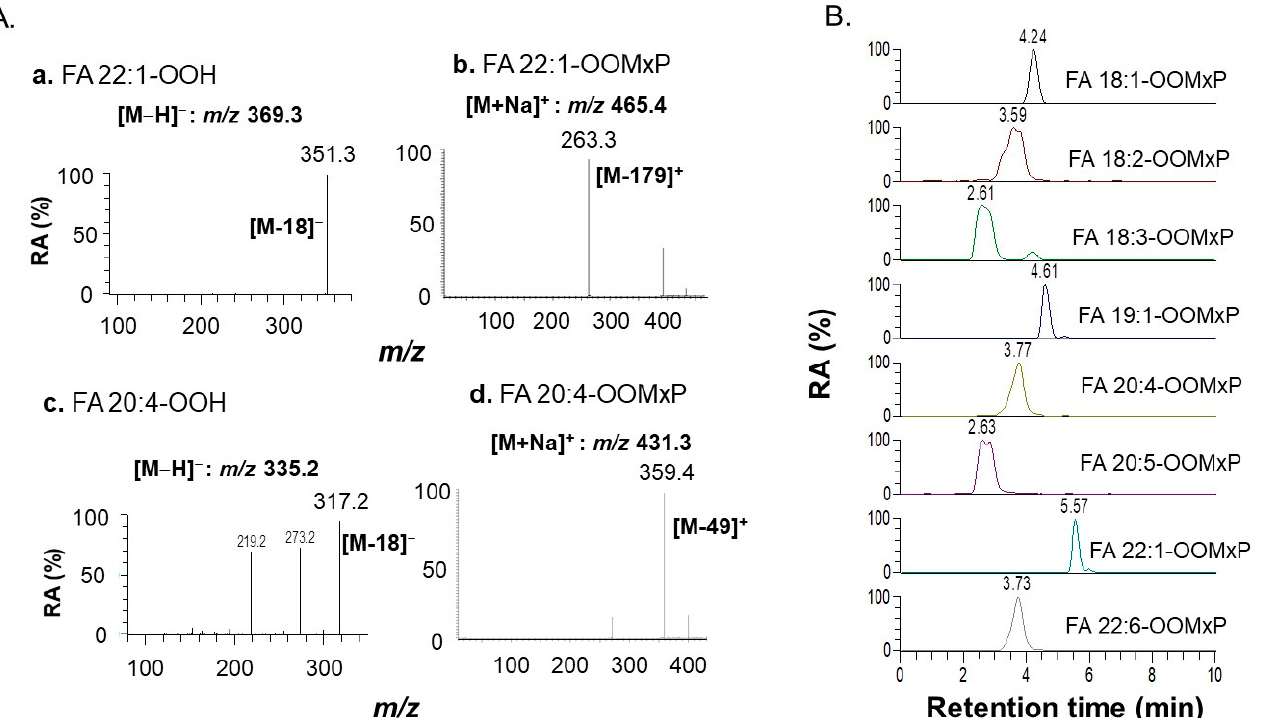
Table 2. Determination of linearity, LOD, and LOQ of FAOOH standards ( # LOD: limit of detection, $ LOQ: limit of quantification).